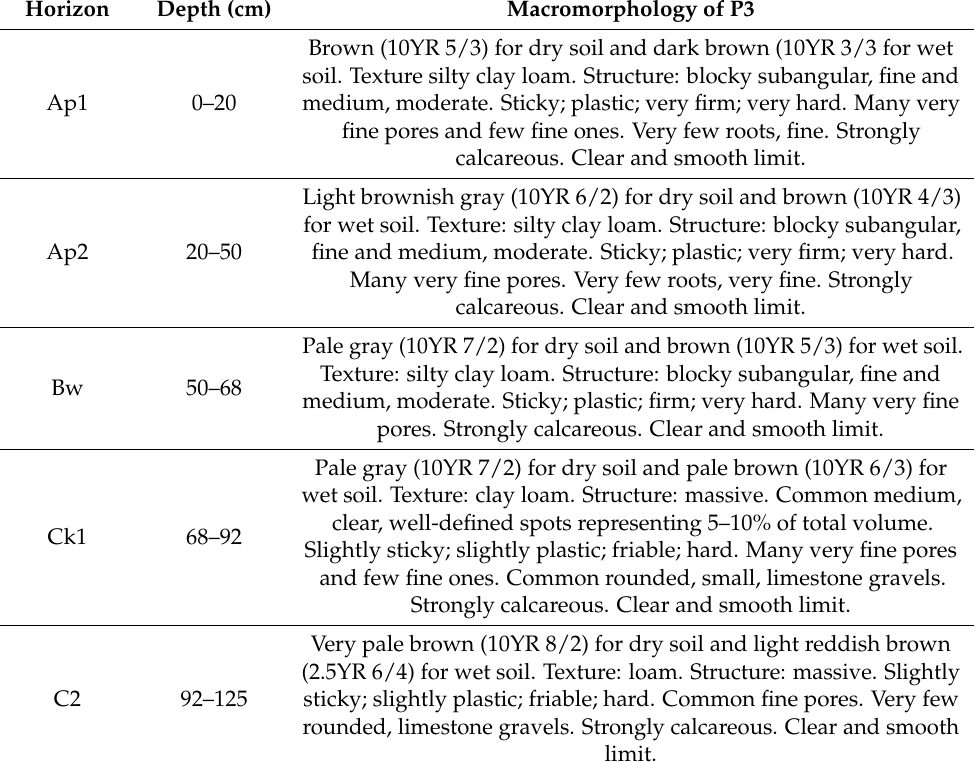
Table A4. Macromorphological description of profile 3